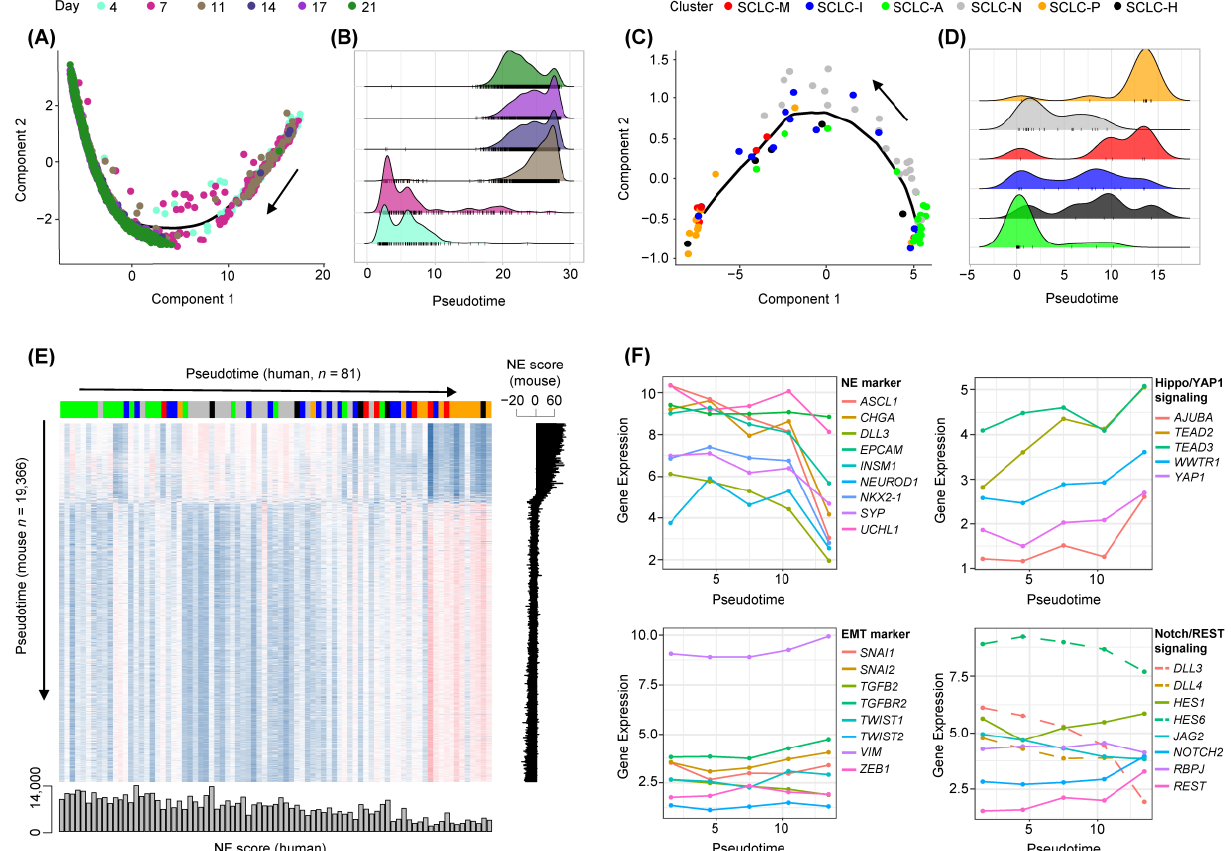
Figure 5. Cross-species analysis of NE to non-NE progression of human and mouse SCLC tumors. ( A ) Pseudotime trajectory of murine SCLC single cell RNA-seq data shows the ordering of cells from early to late time points (Day 4 to Day 21). Black arrow shows an increase in pseudotime. ( B ) Cell abundance is plotted according to pseudotime and segregated cells harvested early (Days 4–7) and late (Days 11–21). ( C , D ) Similarly, the trajectory of human SCLC tumor epithelial cells and cellular abundance along the pseudotime are plotted. Black arrow shows an increase in pseudotime. ( E ) A heatmap shows the correlation in gene expression between human SCLC epithelial cells ( x -axis; 81 samples) and mouse single cells ( y -axis, 19,366 cells), both sorted in order of pseudotime. NE scores representing the transcriptional shift from NE to non-NE decreased consistently with pseudotime. ( F ) Levels of expression ( y -axis, log2-scaled) are shown for NE and EMT markers as well as those belonging to Hippo/YAP1 and Notch/REST signaling pathways. Dashed lines in the Notch signaling pathway indicate Notch-inhibitory